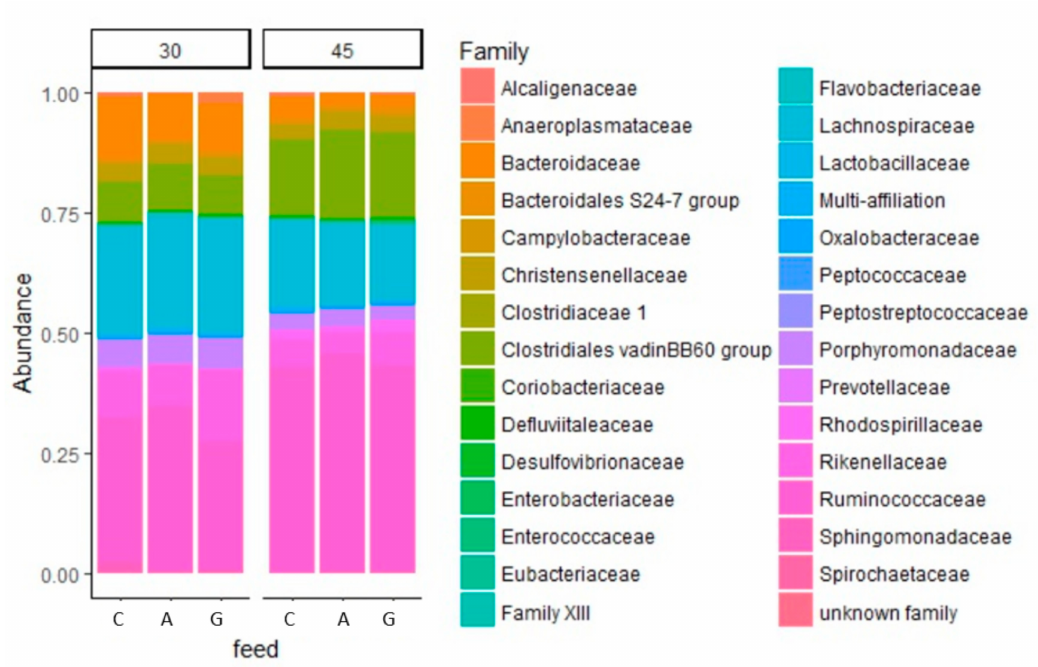
Figure 5. E ff ect of dietary supplementation with dehydrated alfalfa or fresh grass on peri-weaning period on relative abundances (%) of the di ff erent families of rabbit caecal microbiota at 30 and 45 days of age. C = rabbit fed pelleted feed only; A = rabbit fed pelleted feed + dehydrated alfalfa; G = rabbit fed pelleted feed + fresh